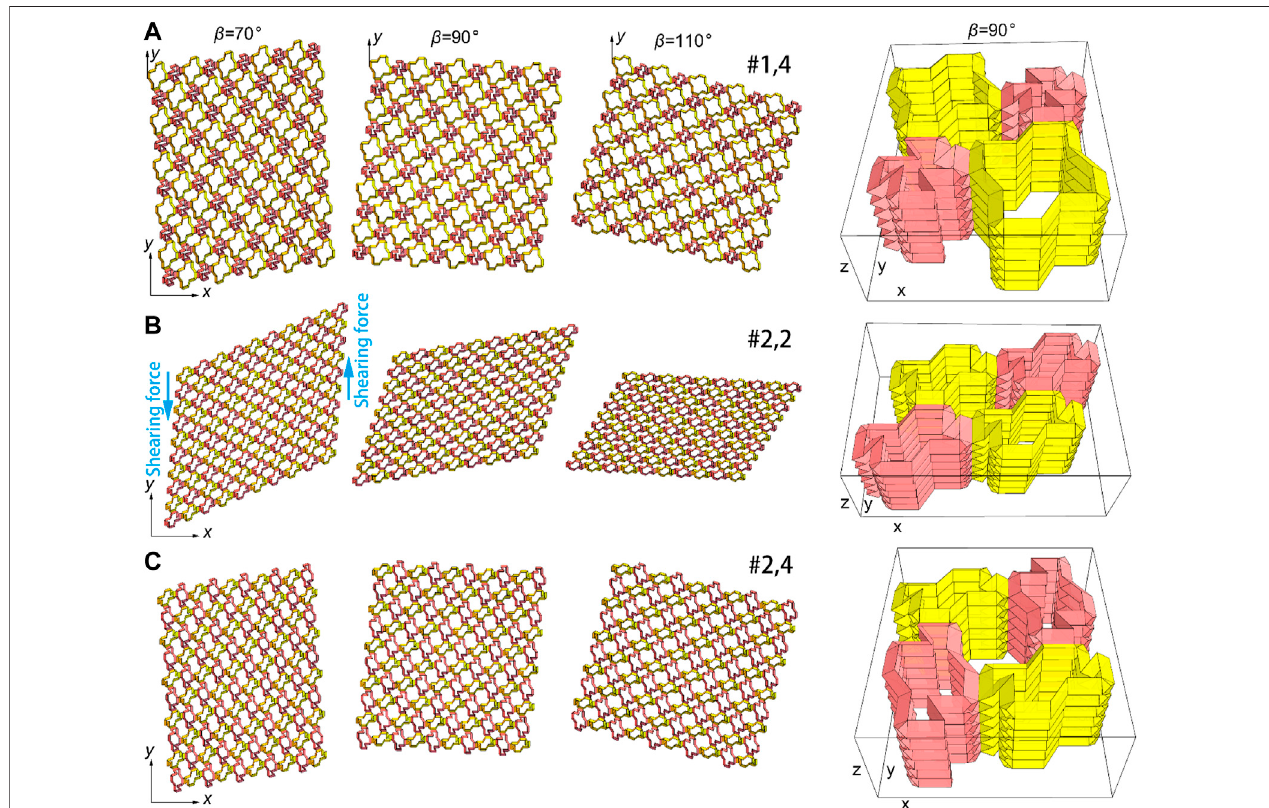
FIGURE 6 | Shearing deformation modes of the 2D cellular structure. Three of the 16 discrete patterns in Figure 5C , (A) #1.4 (B) #2.2 (C) #2.4; column 1 – 3, 2D cellular structures with β (cid:1) 70 ° , 90 ° , and110 ° ; column 4, 3D cellular structures with β (cid:1) 90 ° .